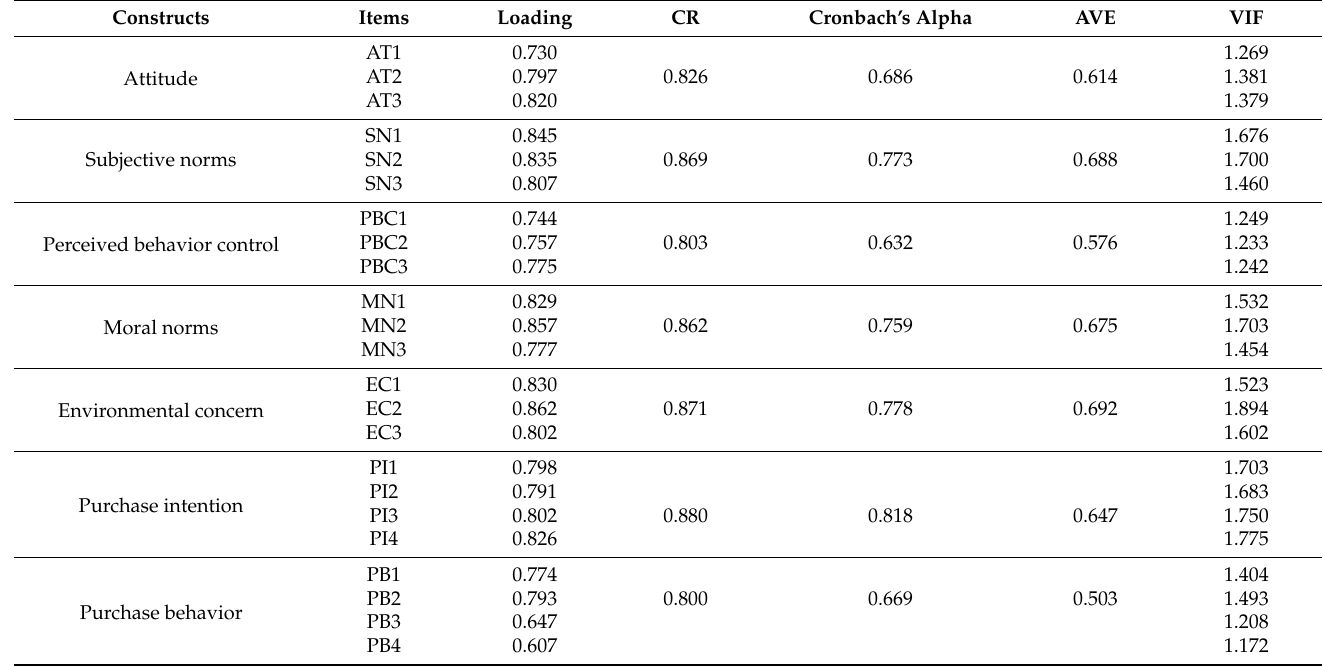
Table 3. the results of the measurement